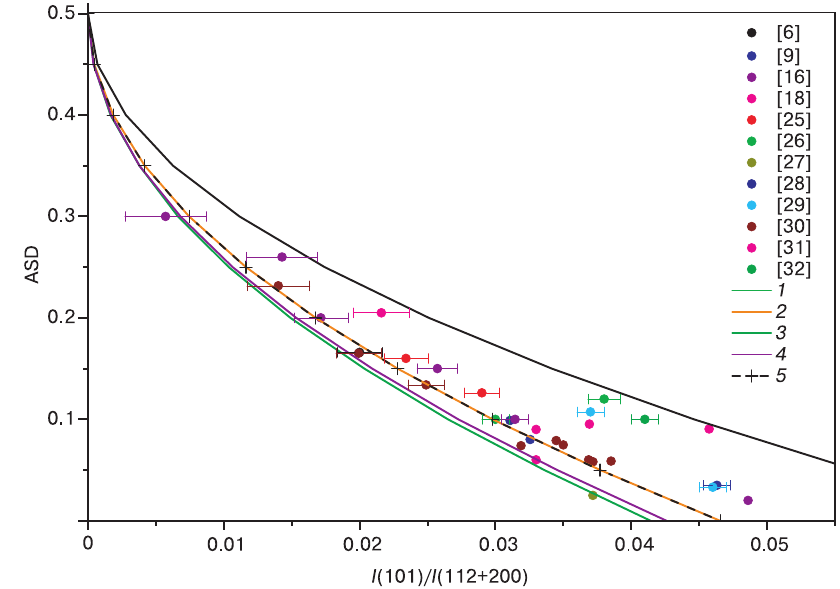
Fe Mo O ( 4 ) calculation 2 0.95 1.05 6-δ